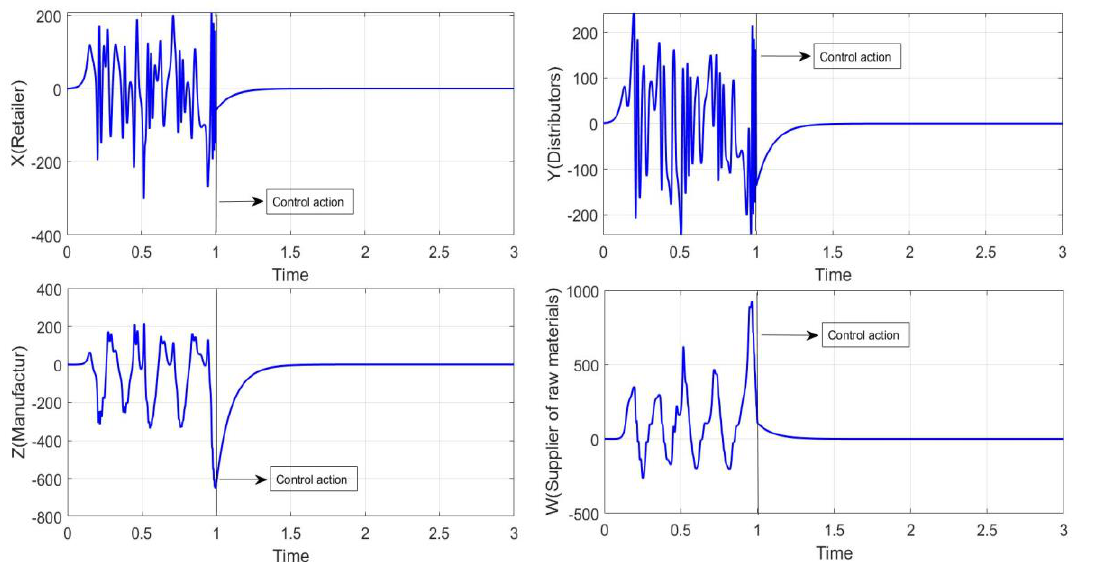
Fig. 9. Elimination of hyper chaotic behavior in the supply chain.